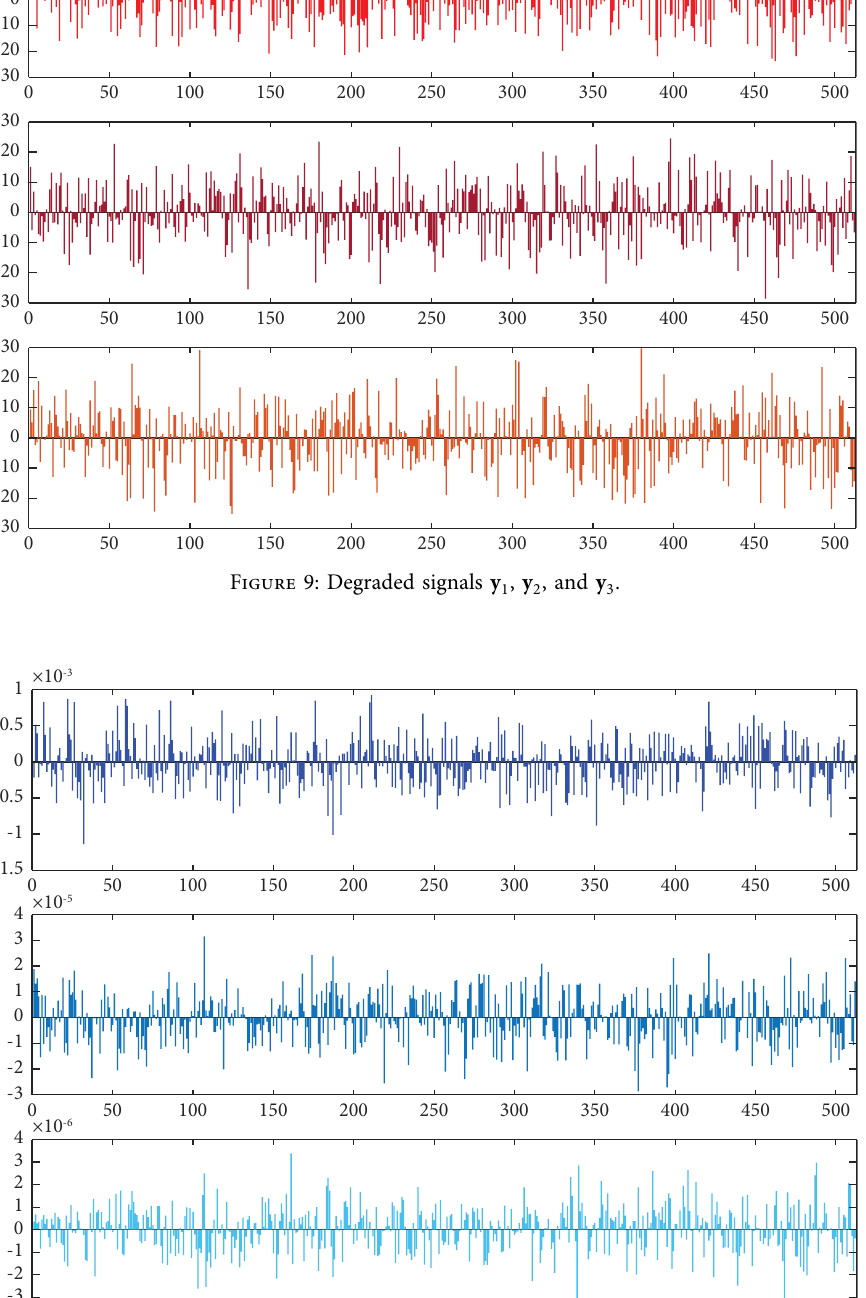
Figure 10: Noise signals ]